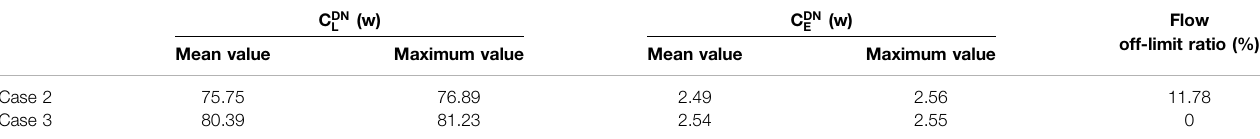
TABLE 7 | Robustness